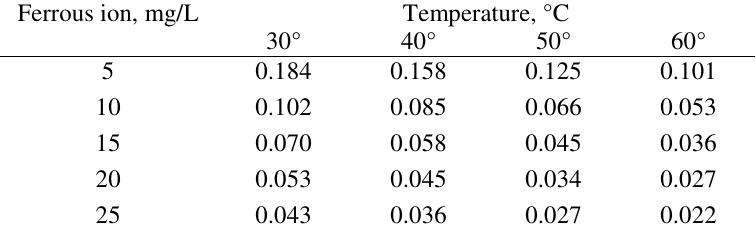
Table 4. Dimensionless separation factor (R